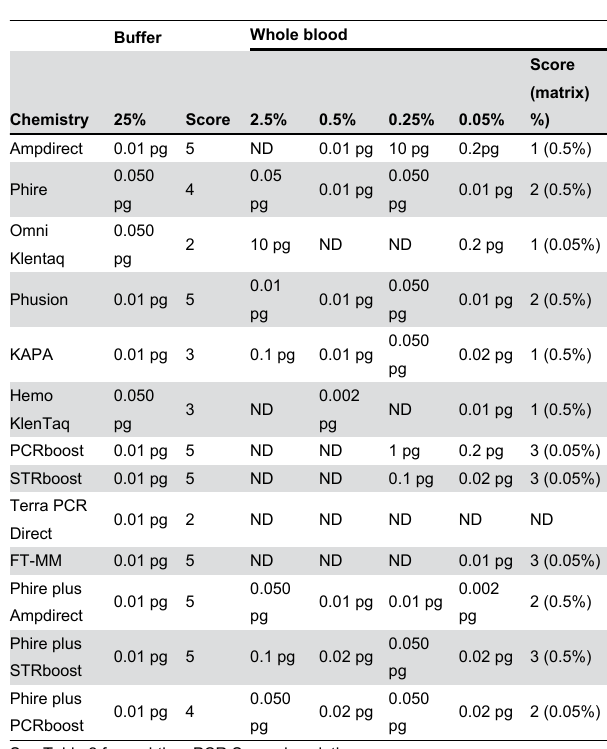
Table 4. Comparison of inhibitor-resistant polymerases with and without Taq DNA polymerase addition in buffer.